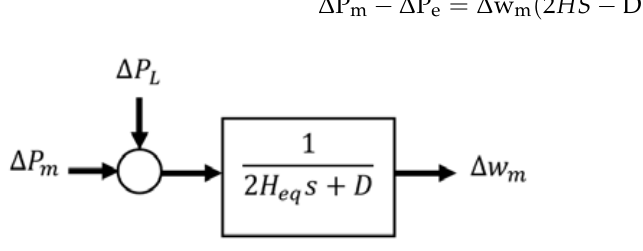
Figure 5. Block diagram of the generator–load dynamic relationship, adapted from [31].